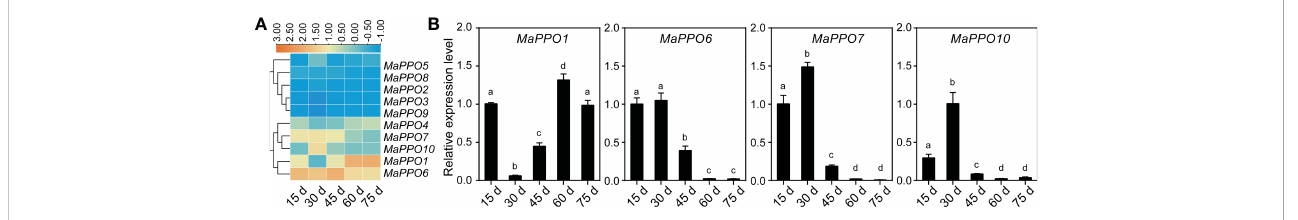
FIGURE 5 Expression pro fi le of MaPPO genes under different fruit developmental stages. (A) Heatmaps indicating the expression levels of MaPPO genes based on transcriptome data. (B) Con fi rmation of the expression levels of MaPPO genes at different developmental stages. Different letters indicate signi fi cant differences (P < 0.05) examined by one-way